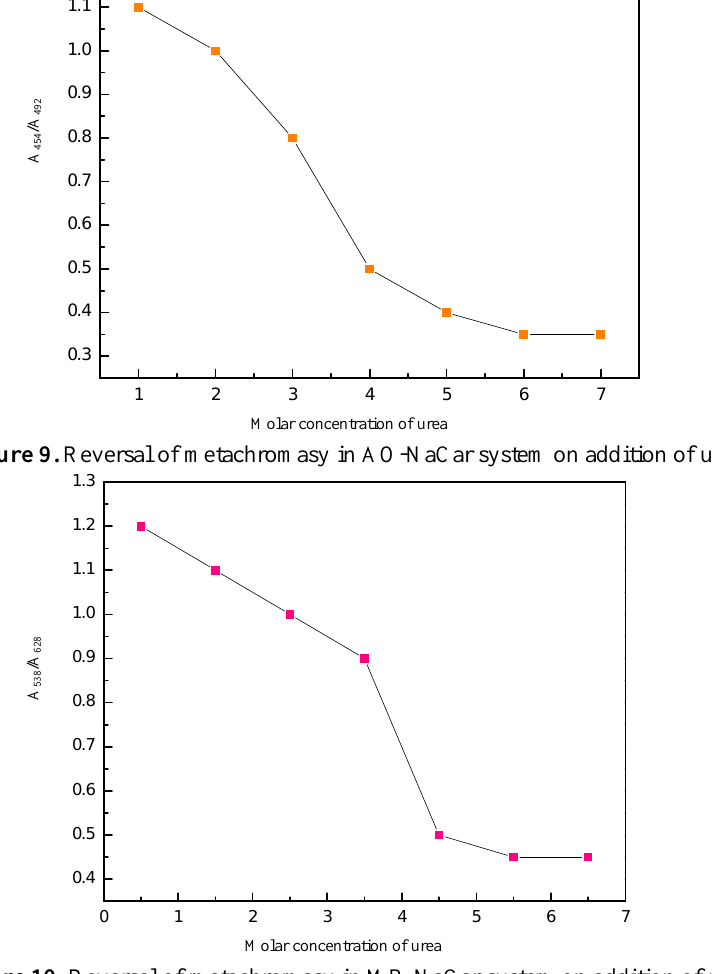
Figure 10. Reversal of metachromasy in MB-NaCar system on addition of